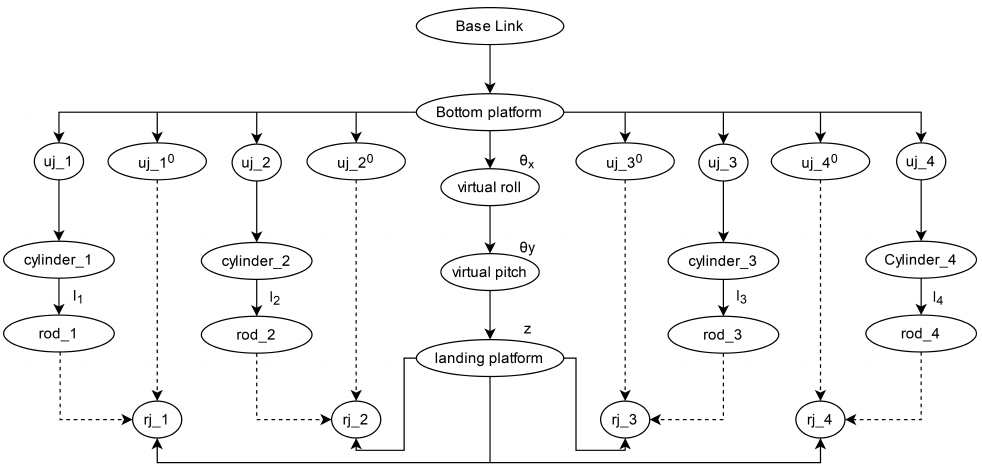
Figure 10. Tree structure of the platform links. Dashed lines—scripted connections.